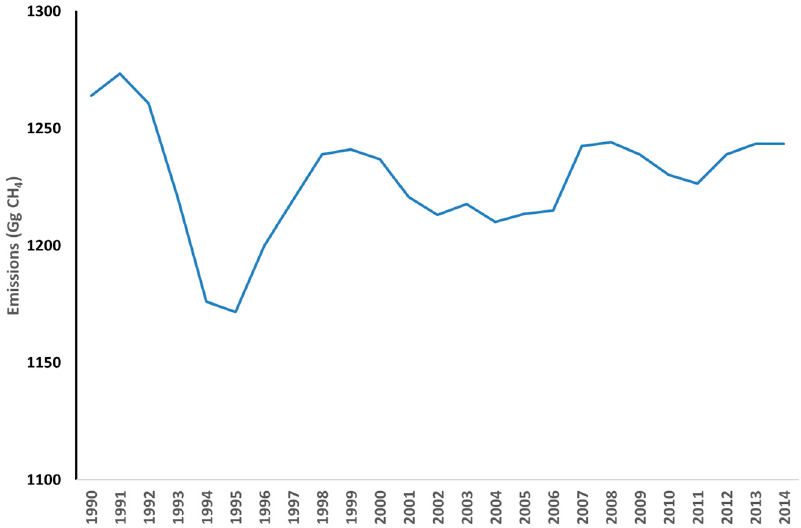
Figure 7. Total enteric emissions (Gg CH 4 ) for South African animals (dairy cattle, non-dairy cattle, horses, donkeys and pigs) from 1990 to 2014.